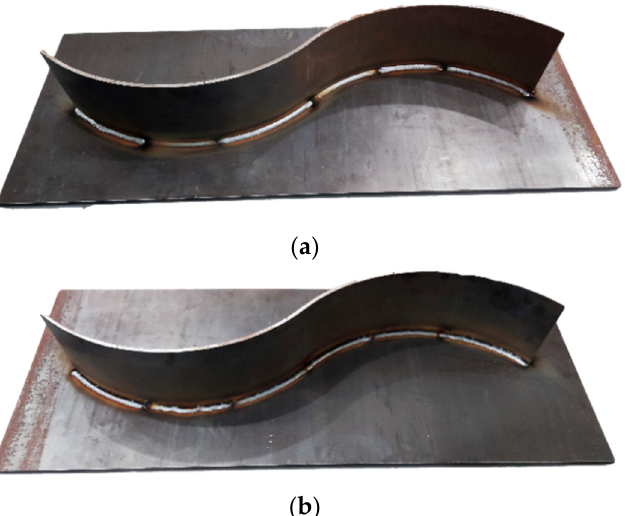
Figure 17. Contour comparison curves under welding sequence “ ①②③④⑤⑥ ”.